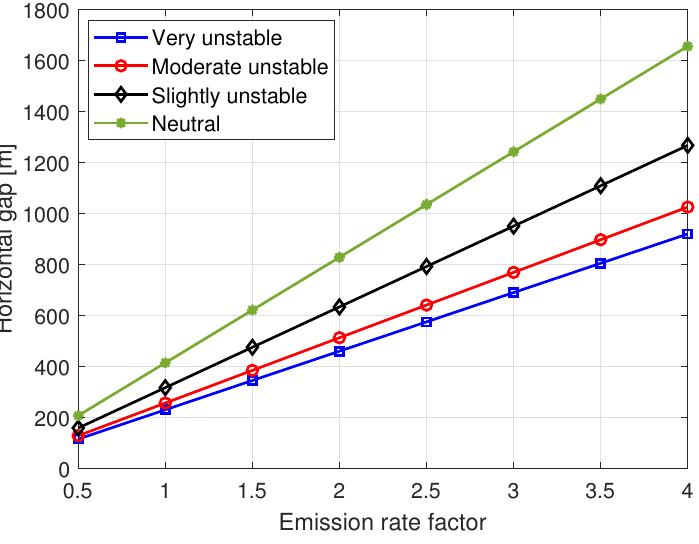
Figure 9. The horizontal gap versus the emission rate factor for various stability